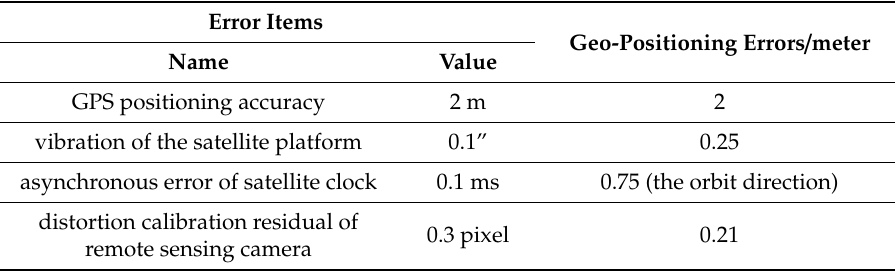
Table 1. Geo-Positioning Errors Decomposition.